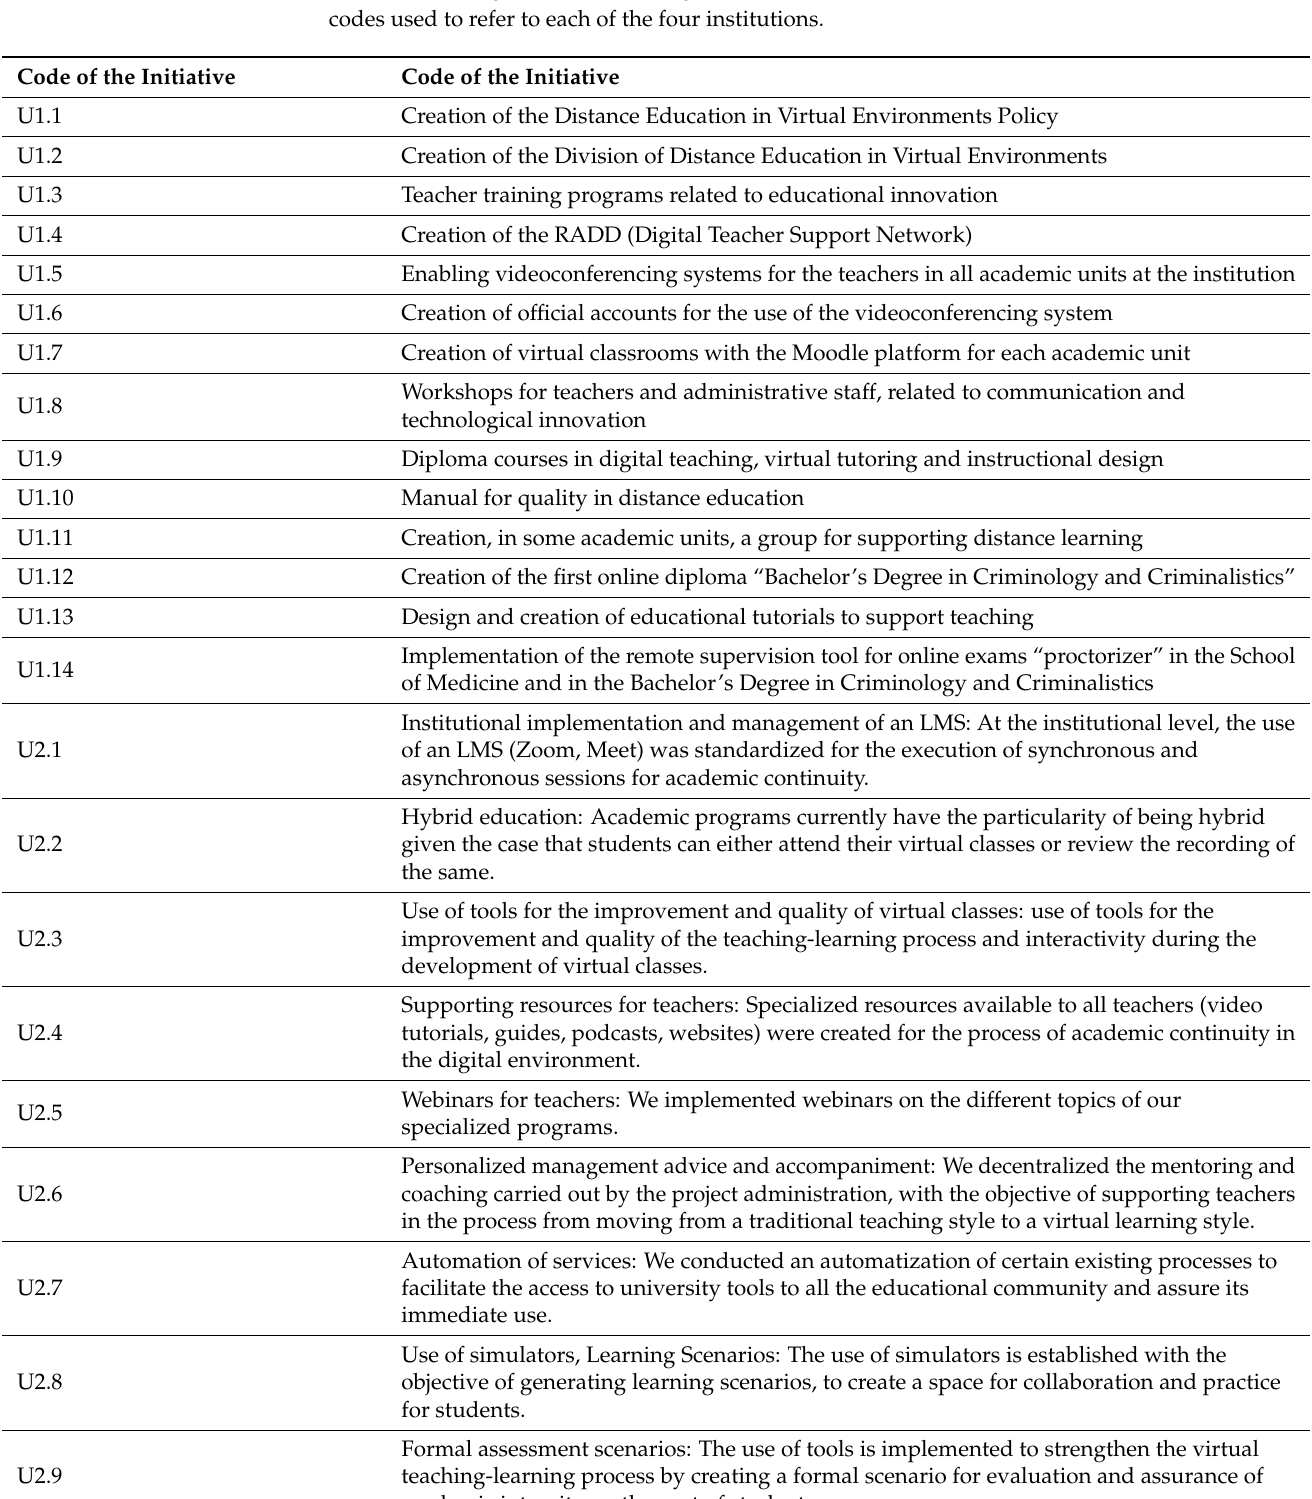
Table A6. Original list of initiatives collected through the [Pre&Post Pandemic Lockdown